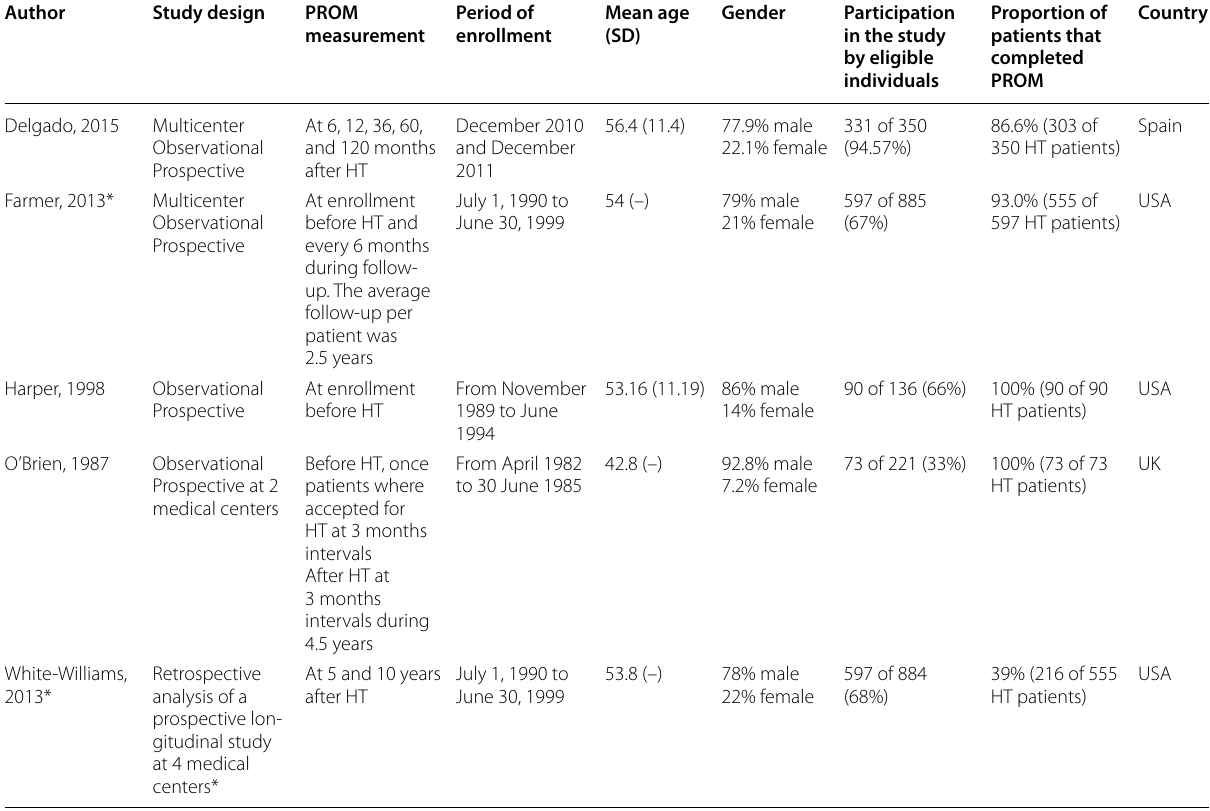
Table 3 Characteristics of the included studies